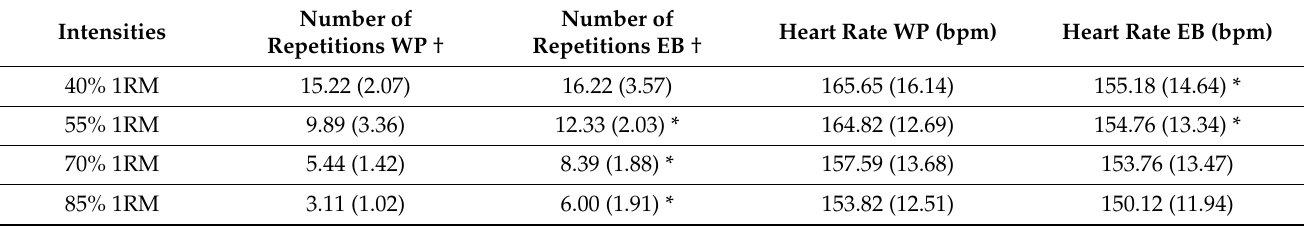
Table 1. Number of repetitions and heart rate in each condition.